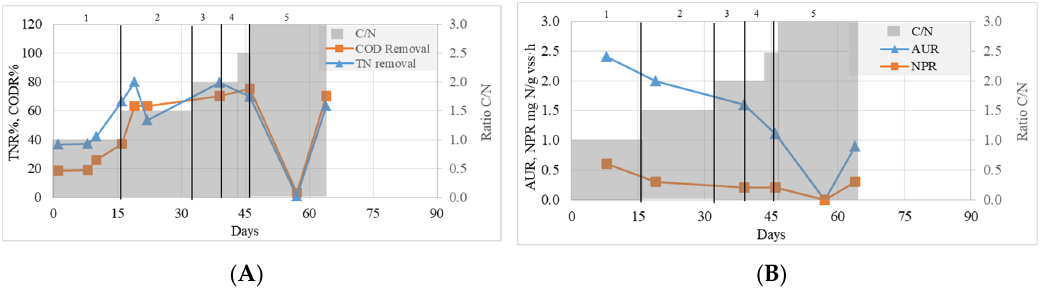
Figure 3. C/N ratio, COD (chemical oxygen demand) and TN (total nitrogen) removal efficiencies ( A ) AUR (ammonium utilization ratio) and NPR (nitrate production rate) ( B ) values in each phase of the 2nd series.